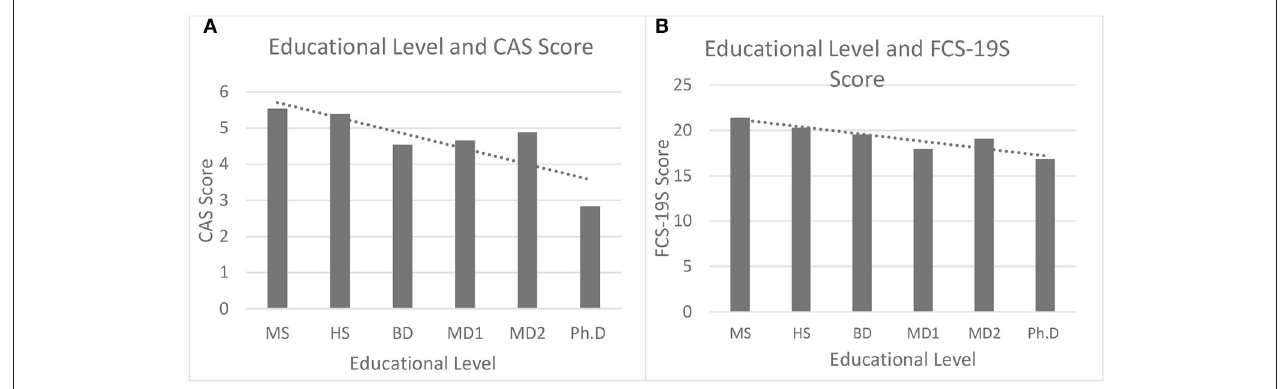
FIGURE 3 | The relationship between the level of education and CAS scores (A) and FCS-19S scores (B) . MS, Middle School; HS, High School; BD, Bachelor’s Degree; MD1, Master’s Degree; MD2, 1st or 2nd level Master’s Degree; PhD, PhD.; CAS, Coronavirus Anxiety Scale; FCS-19S, Fear of COVID-19 Scale; COVID-19, coronavirus disease 2019.